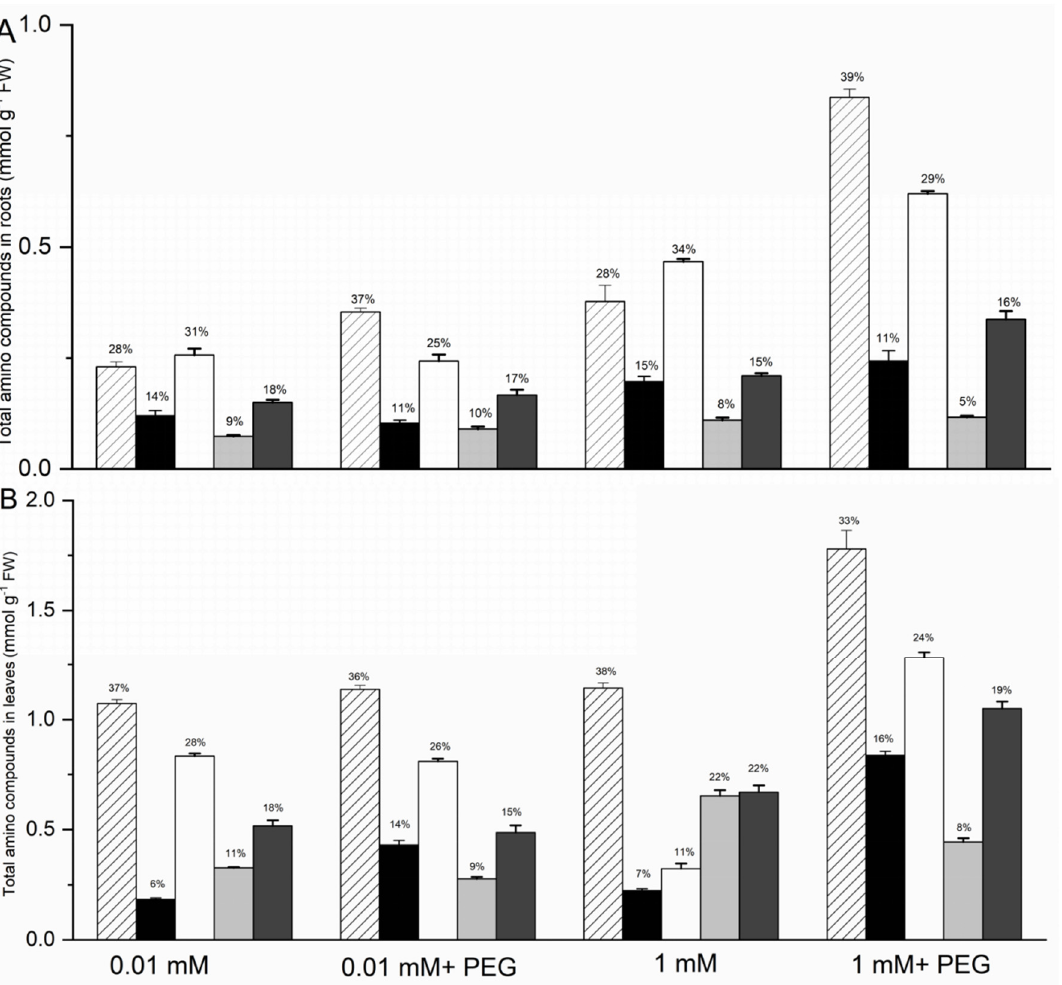
Figure 2. Amino compounds in roots ( A ) and leaves ( B ) of Populus simonii as affected by nitrogen supply and drought stress. Amino acids deriving from the same pathway are grouped together. The percent distributions of these biosynthetic groups are presented, as well as the mean values of sums of amino compounds of each group of three plants and SE. (Striped) aspartate, threonine, isoleucine, methionine, lysine; (black) serine, glycine, cysteine; (white) glutamate, histidine, arginine, proline; (light grey) phenylalanine, tyrosine; (dark grey) alanine, leucine, valine. In the leaves, the serine group showed a higher absolute (1.5-fold) and proportional (from 6% to 14%) content in response to drought stress under 0.01 mM NH 4 NO 3 (Figure 2B). Osmotic stress also increased the total amino acid content of most biosynthetic groups (except the tryptophan group) under 1 mM NH 4 NO 3 (Figure 2B). Under 1 mM NH 4 NO 3 ,